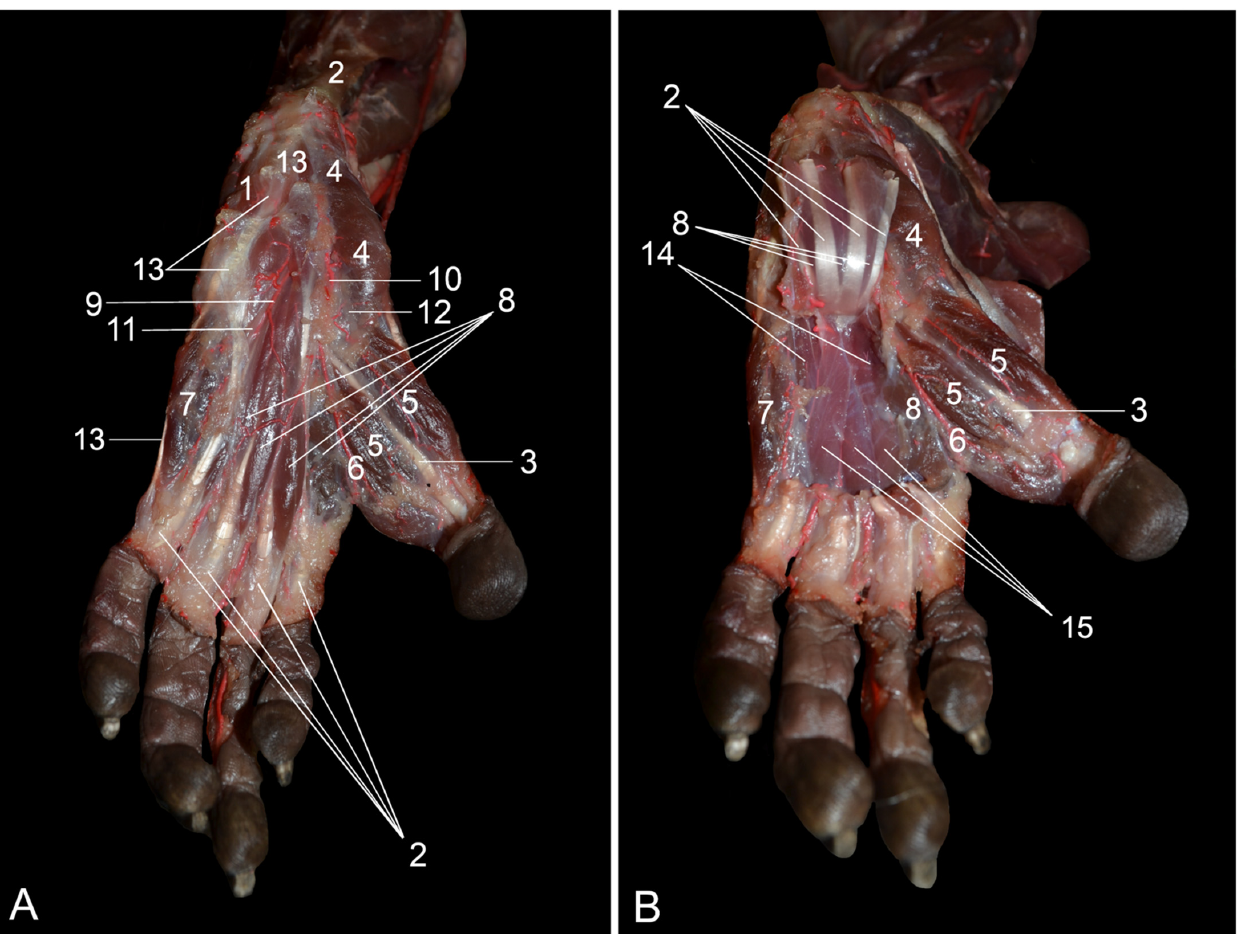
Figure 10. Plantar views of the left foot. ( A ) Superficial layer; ( B ) deeper layer after the tendons of the m. flexor digitorum medialis/tibialis and the mm. lumbricales pedis were proximally